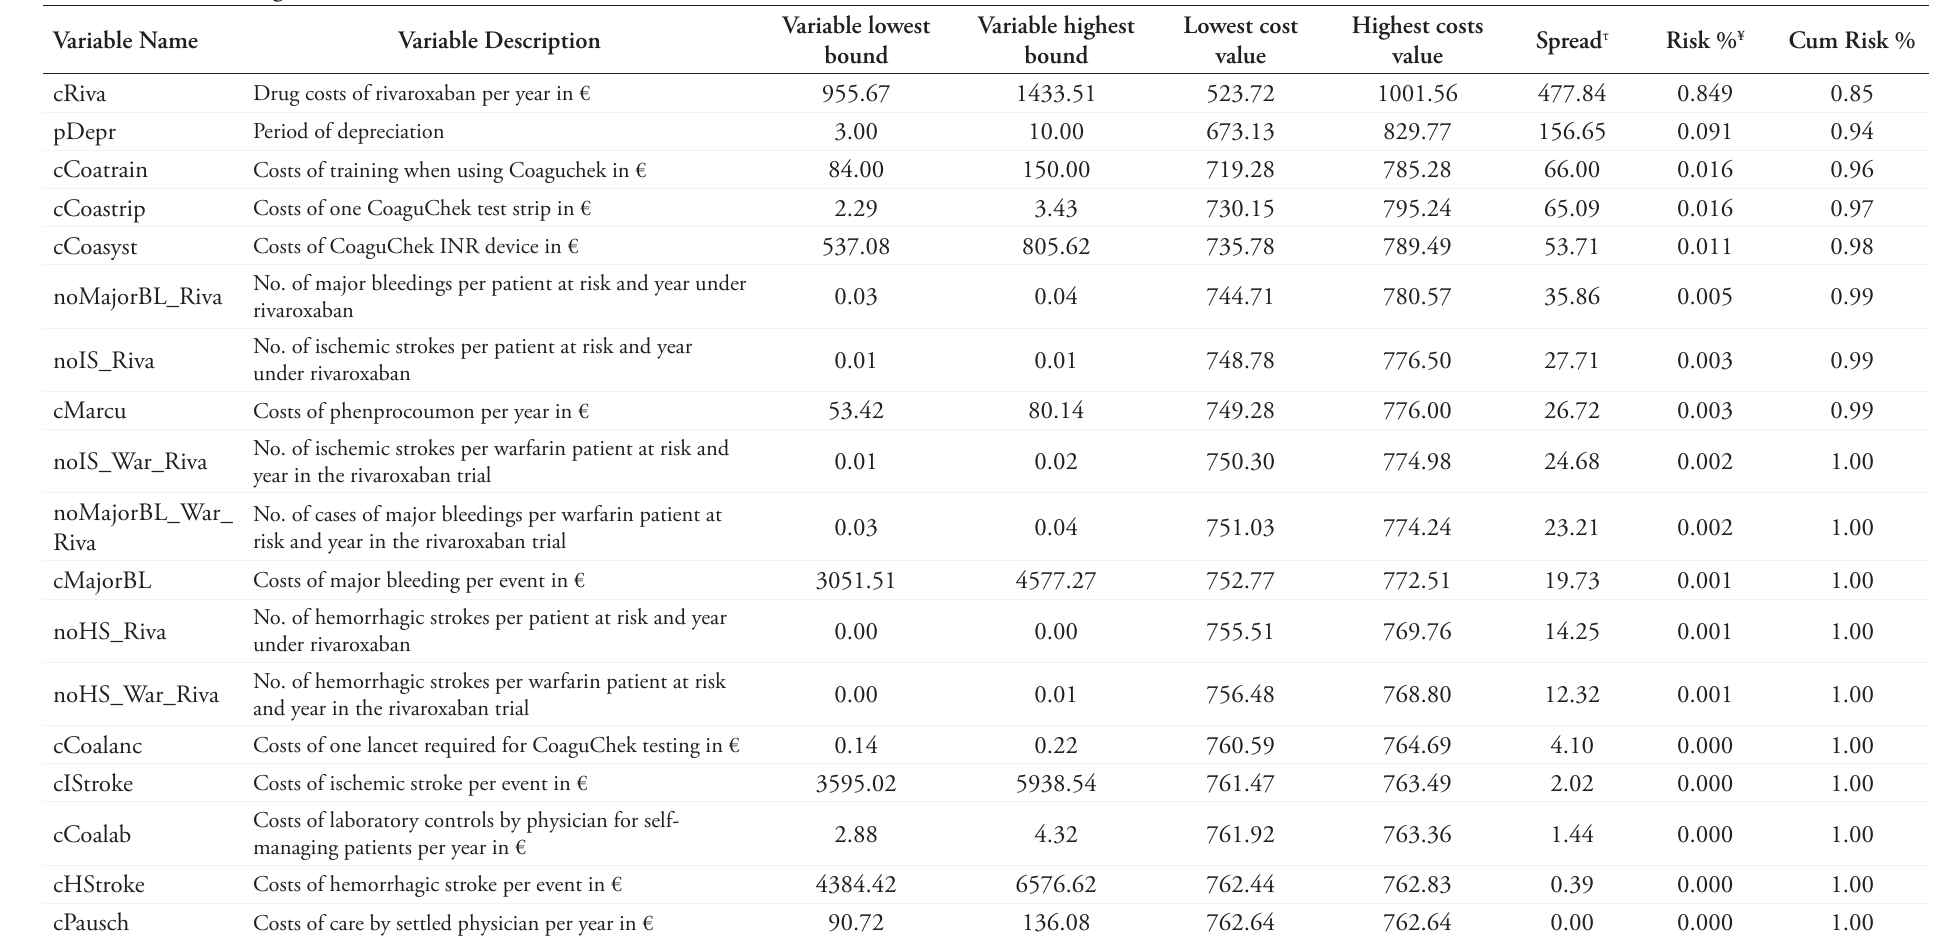
Table 5d: Tornado diagram*: VKA under PST versus